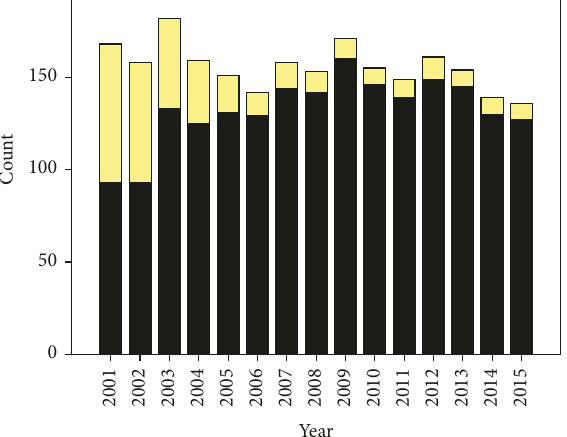
Figure 2: Proportions of the women who accepted TOLAC (yellow) and not accepted TOLAC (black) in each year.